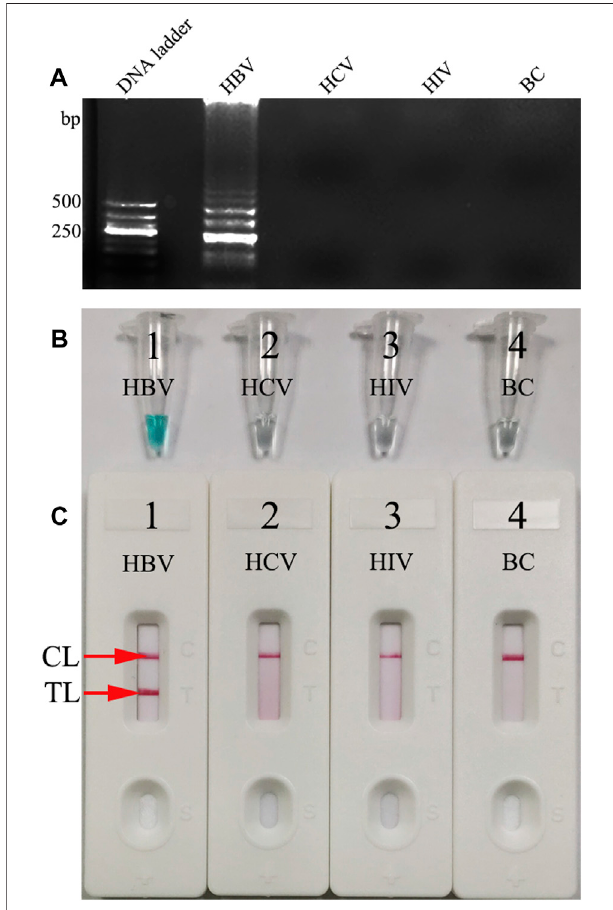
FIGURE 4 | Determination and con fi rmation of HBV-LAMP products. The HBV-LAMP products were analyzed by 2% agarose gel electrophoresis (A) with the MG reagent (B) and LFB (C) . Lane DNA ladder: 500-bp DNA ladder; the ladder-like bands indicate positive LAMPs (A) . The color change from colorlessness to bright green indicates positive nucleic acid ampli fi cations (B) . Two visible red lines (CL and TL) appeared for positive results (C) . However, there was no band in gel electrophoresis (A) , the color remains colorless (B) , and only the CL was observed (C) in NC and